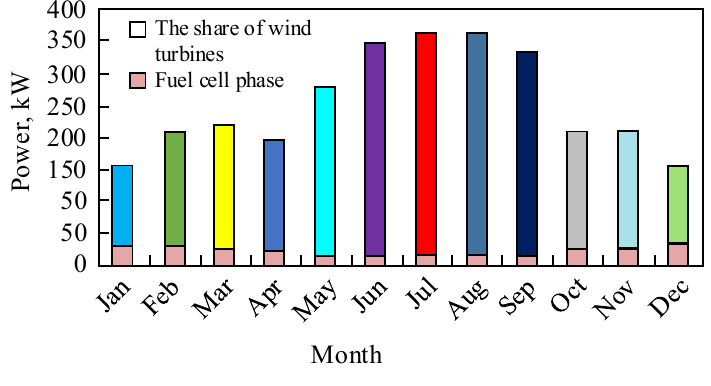
Fig. 8. The share of wind turbine and fuel cell production in different